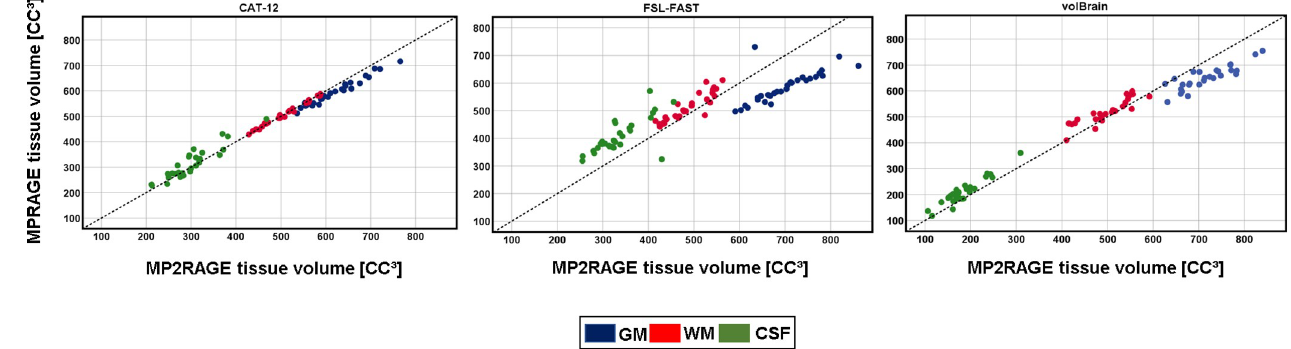
Fig 2. Scatter plots demonstrating GM (blue), WM (red), and CSF (green) volumes measured by the different segmentation tools based on MP-RAGE and MP2RAGE sequences. Points above the identity line (dashed) indicates higher volumes were calculated in MP-RAGE vs . MP2RAGE, while points below the line indicate higher values based on. MP2RAGE vs.